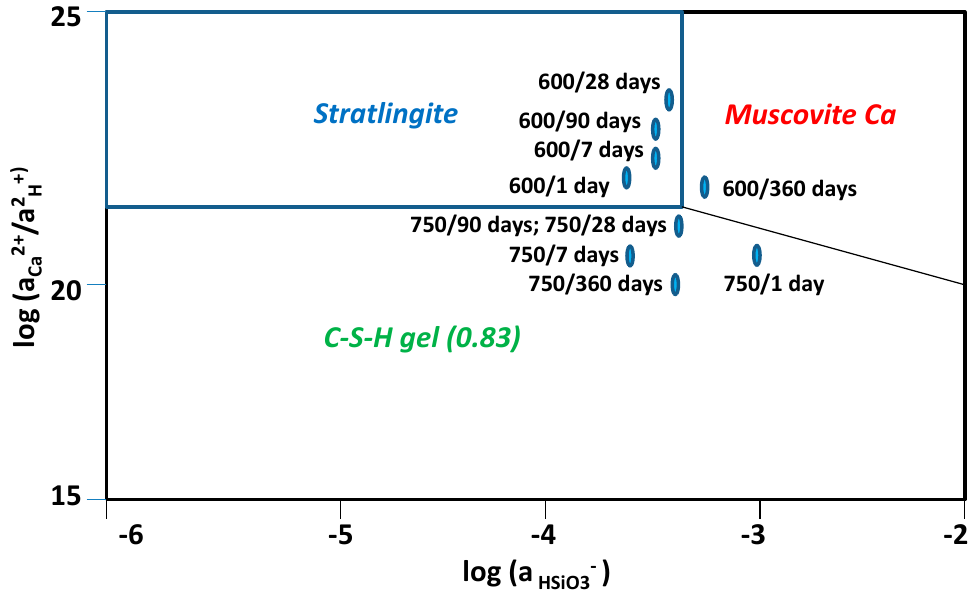
Figure 14. Plot of stability fields for muscovite Ca + stratlingite + C-S-H gel system from the chemically and thermally activated kaolin.